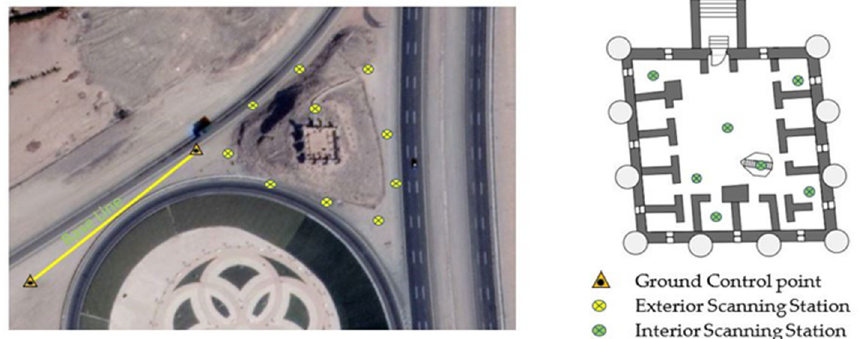
Figure 11. The layout of the control points and scanning stations.